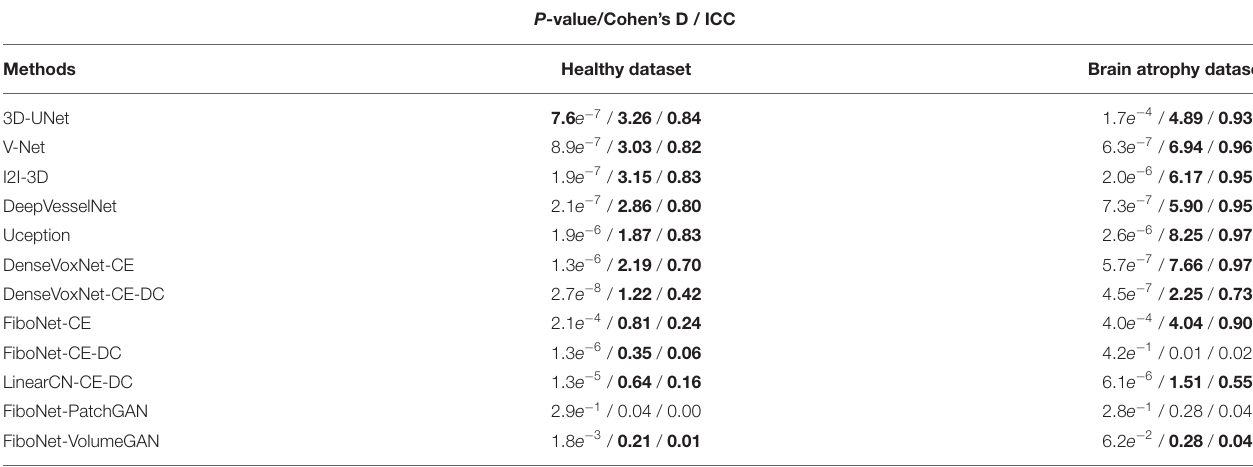
TABLE 4 | P -value, Cohen’s D, and intraclass correlation coefficient (ICC) values between the proposed method, FiboNet-VANGAN, and each of its counterparts. P -value/Cohen’s D /